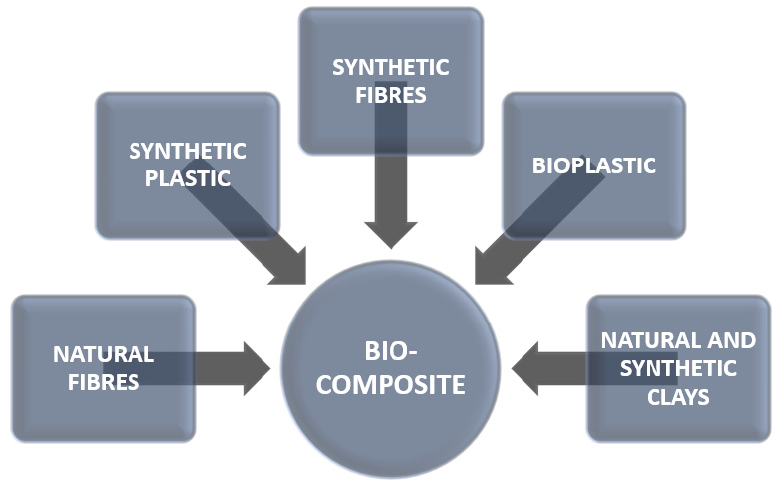
Figure 4. Variety of biocomposite processing pathways. Data adapted from [13].